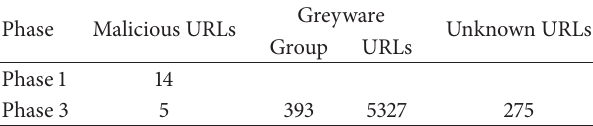
Table 3: Experimental